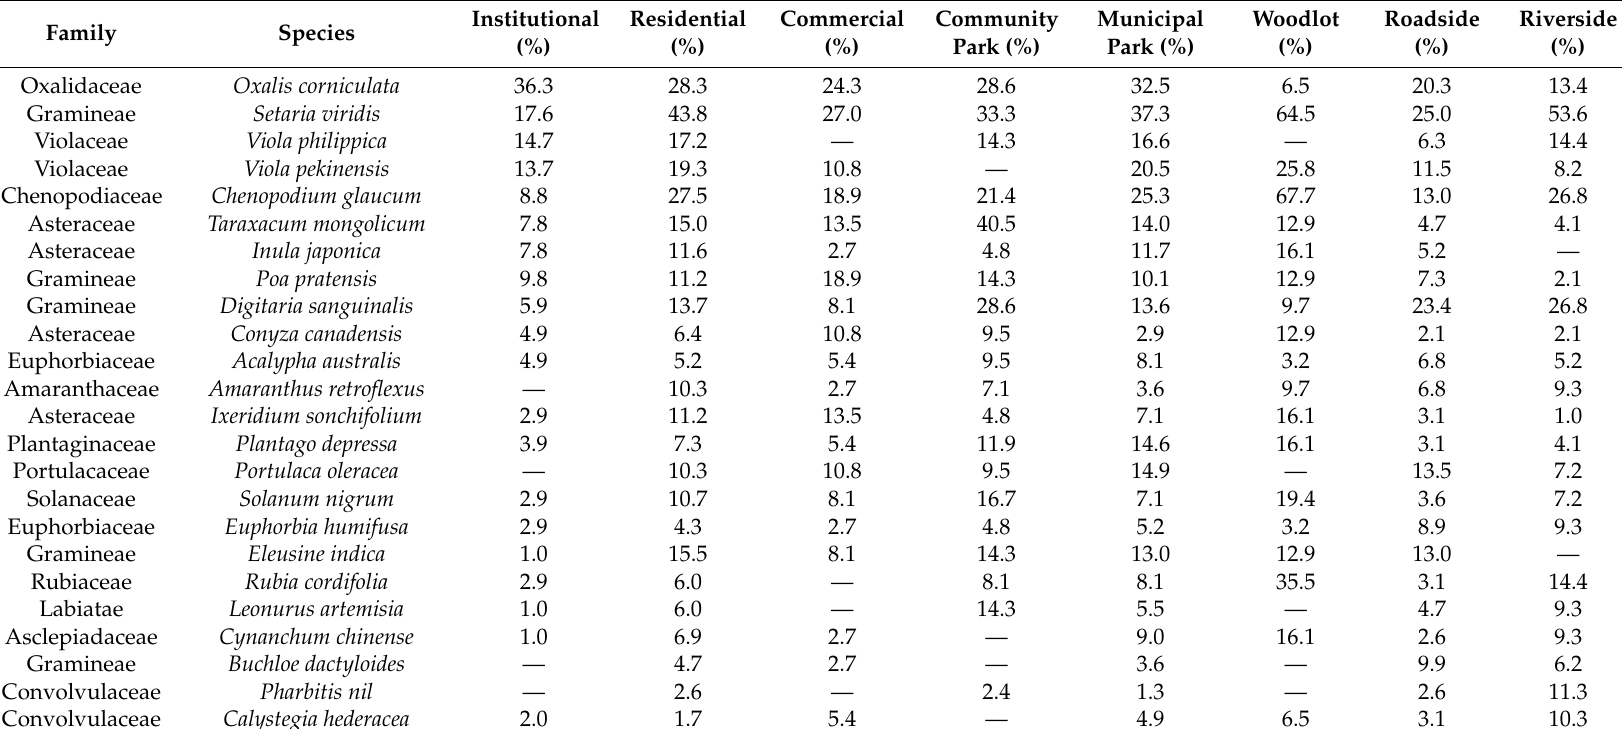
Table 1. The frequency of ruderal species in different